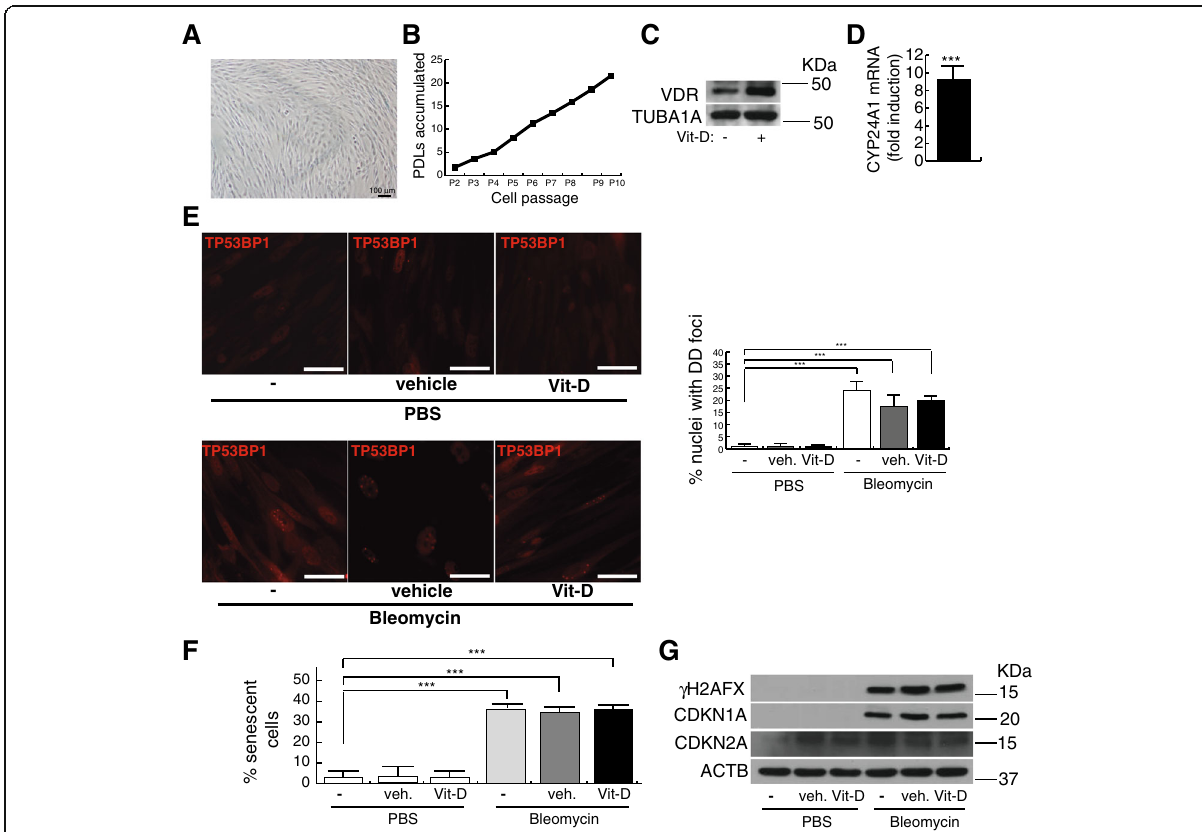
Fig. 3 Effects of vitamin D and bleomycin in human myofibroblasts. a Representative micrographs of a typical myofibroblasts culture. Scale bar: 100 μ m. b Accumulation of population doubling levels (PDLs) during ten consecutive passages. c Detection of vitamin D receptor (VDR) in myofibroblasts extracts. TUBA1A (tubulin α was used as loading control. KDa: kilodaltons. d RT-qPCR result: expression of CYP24A1 in myofibroblasts cultures treated with 5 nmol/L vitamin D. Values are relative to cells treated with vehicle. e Expression of TP53BP1 foci (red dots) in cultures of myofibroblasts pretreated with 5 nmol/L vitamin D for 2 h, subjected to a bleomycin shock (12 μ g/mL for 6 h) and then treated with 5 nmol/L vitamin D or its vehicle. Representative micrographs taken at 48 h post-shock are shown. Scale bar: 20 μ m. Right panel: quantification of damaged cells (nuclei with TP53BP1 foci). f Quantification of the senescence levels (% of SA- β gal + cells). Myofibroblasts were pretreated with